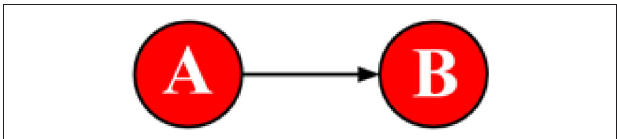
FIGURE 6 | A simplified example of a directed graph.